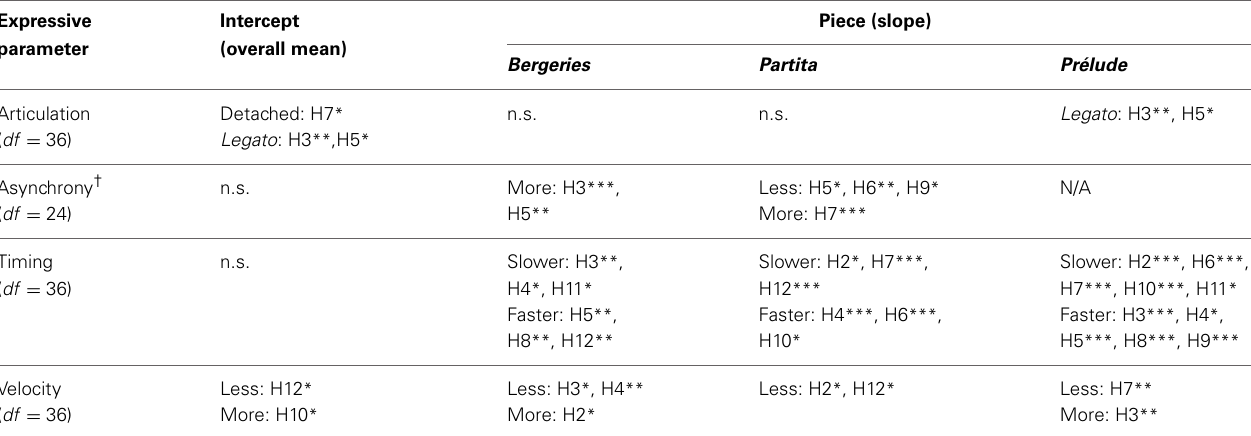
Table 2 | Individual random effects associated with each performer.